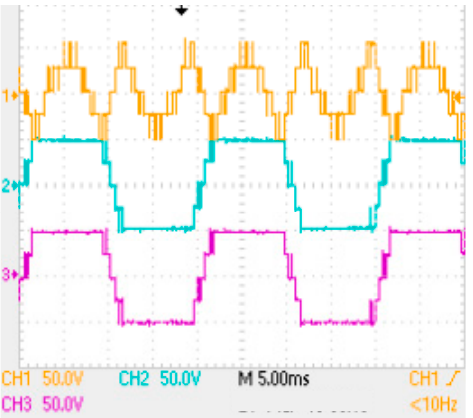
Module 2; CH3: port voltage of Module 3; CH4: whole port voltage).